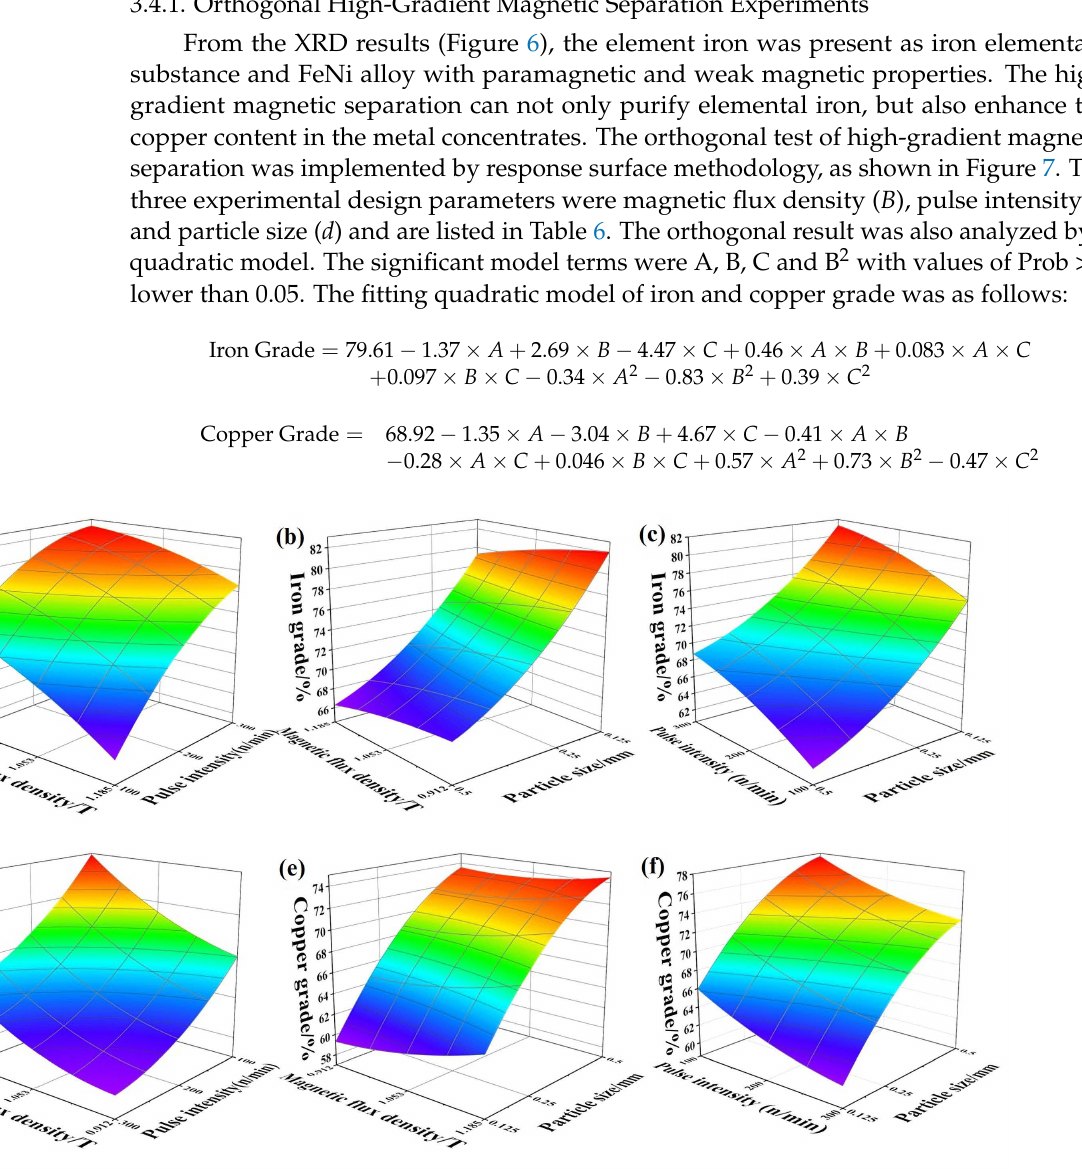
Figure 7. The response surfaces of the experimental factors of high-gradient magnetic separation. The relationship between iron grade and test conditions was shown in ( a – c ); and the relationship between copper grade and test conditions was shown in ( d – f ). Table 6. Test factors and levels of high-gradient magnetic separation